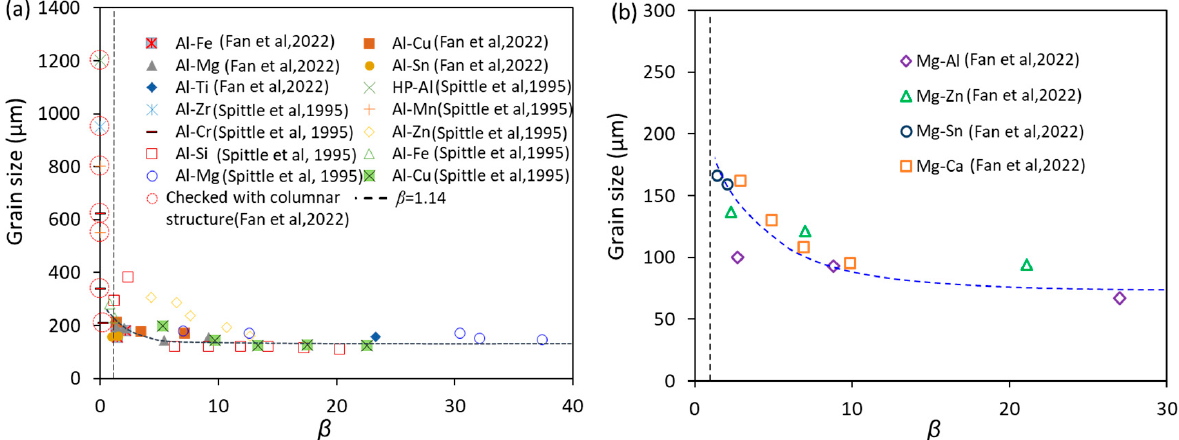
Figure 5. Experimentally measured grain size as a function of growth restriction parameter, β , in ( a ) Al alloys and ( b ) Mg alloys [9]. The grain size was measured from TP-1 test samples of Al alloys inoculated with the potent TiB 2 particles (number density of 10 13 m − 3 ) and Mg alloys with intensive melt shearing (MgO number density is 10 17 m − 3 ). Experimental data are from Refs. [9,24]. The microstructure changes abruptly from columnar to equiaxed around β =